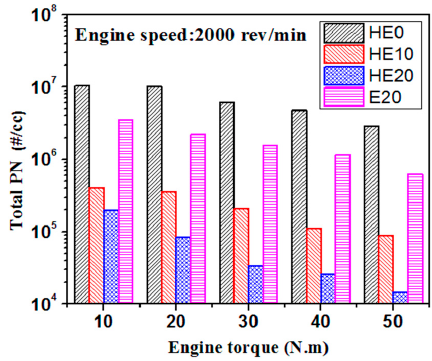
Figure 5. Difference of total particulate number (PN) concentration with engine load.